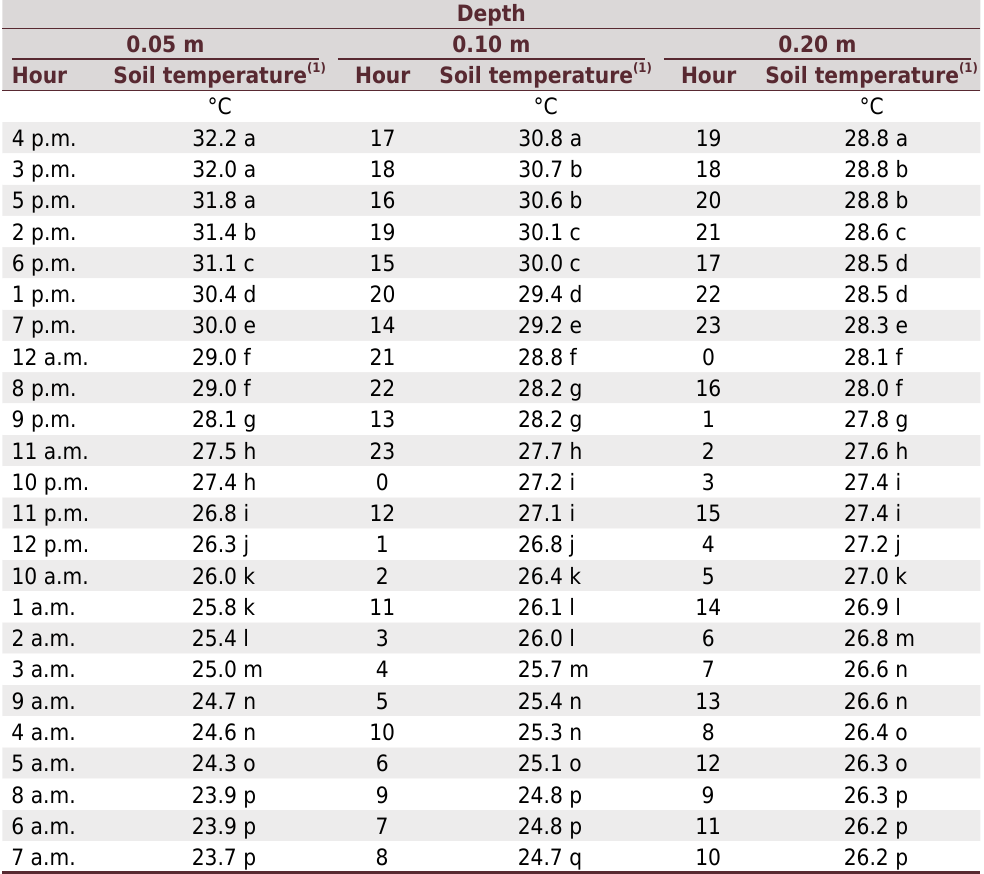
Table 4. Mean hourly soil temperature for all months and for different depths, from February 04, 2014, to September 30, 2015, in a Cambissolo Háplico Ta Eutrófico (Cambisol; Inceptisol) in São Gabriel, Irecê Identity Territory, Bahia,